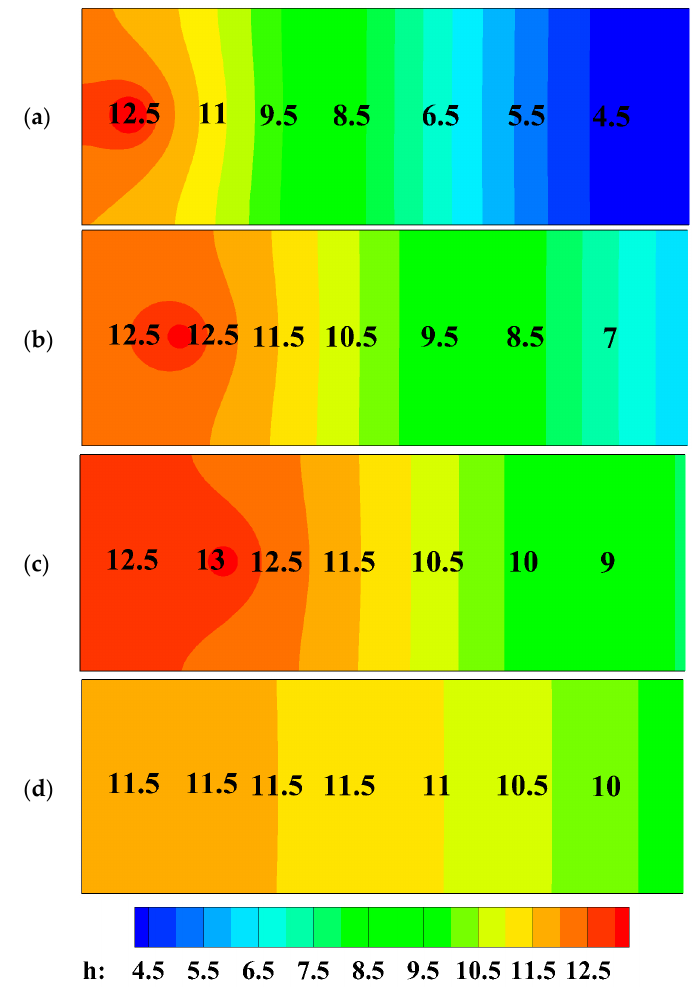
Figure 10. Evolution of the heat transfer coefficient, h (W/m 2 K), at instants ( a ) 7.8 s, ( b ) 15.6 s, ( c ) 23.4 s, and ( d ) 39.0 s for t + = 2.0 ms.